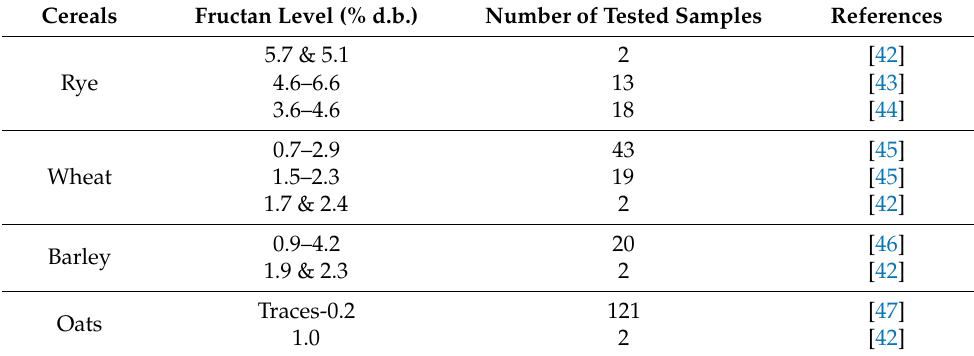
Table 2. Fructan level (% dry basis) in wholegrains of different cereals.